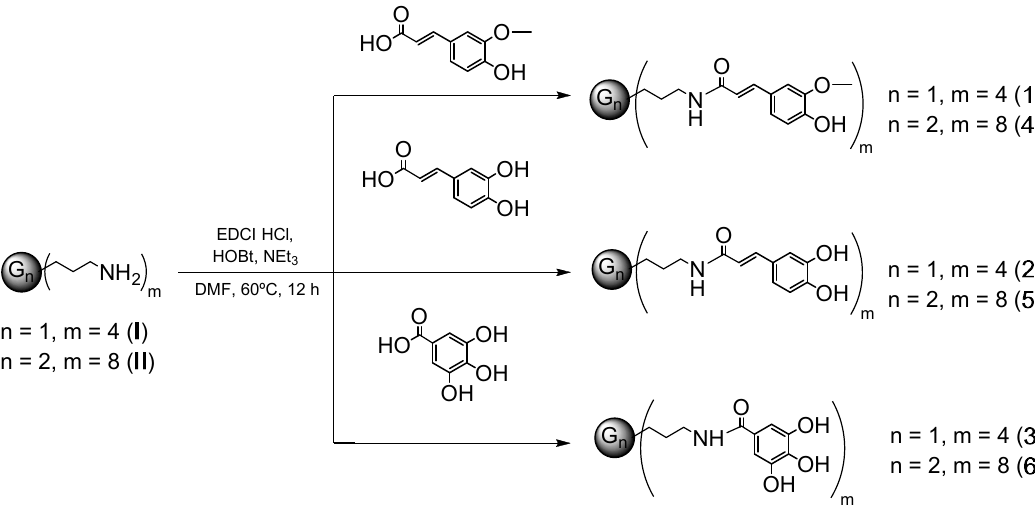
Figure 1. Proposed structures for polyphenolic carbosilane dendrimers ( 1 ‒ 6 ). The 1 H-NMR, 13 C-NMR, 1 H-DOSY-2D-NMR spectra confirmed the formation of new polyphenolic dendritic families. The NMR spectra of the first-generation polyphenolic dendrimer functionalized with caffeic acid ( 2 ) are reported in Figure 2 as an example.